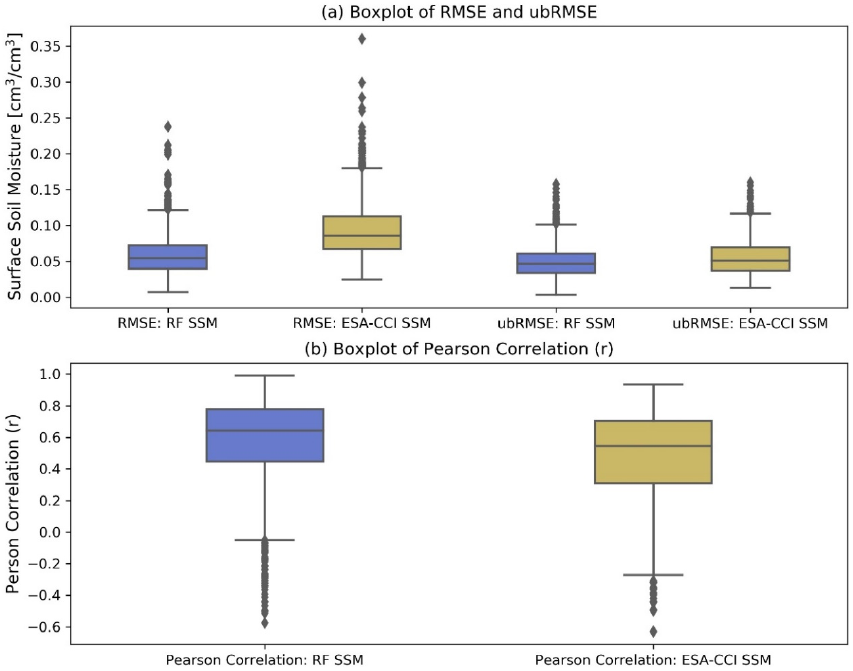
Figure 4. Boxplot of the metrics of the validation & evaluation set: RF SSM vs. ESA-CCI. ( a ) boxplot of RMSE, ubRMSE, ( b ) boxplot of r, the RF model considering geographical coordinates. The predicted SSM and ESA CCI SSM time-series have been plotted along with the in situ SSM to evaluate the performance of temporal variability of predicted SSM. Figure 5a shows the comparison at the station Versailles-3-NNW, in the humid subtropical zone (Cfa) and covered with grassland. Both the RF SSM and ESA-CCI SSM capture the annual or interannual variabilities reasonably well, and RF SSM could predict some detailed in- formation in the spring and autumn. In other stations, the RF SSM overperforms ESA-CCI SSM, e.g., the station GoodWinCreekPasture of SCAN in Figure 5b, the station node403 of SoilSCAPE in Figure 5c, and the station DryLake of SNOTEL in Figure 5d, covering various climate zones (humid subtropical zone (Cfa), hot-summer Mediterranean climate (Csa), humid continental climate (Dfb).